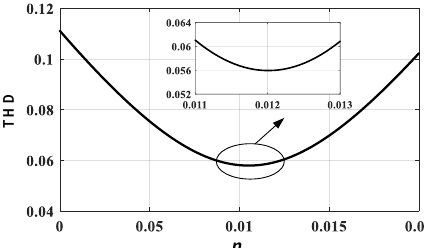
Figure 9. The relationship between the THD of input voltage and the turn ratio of injection